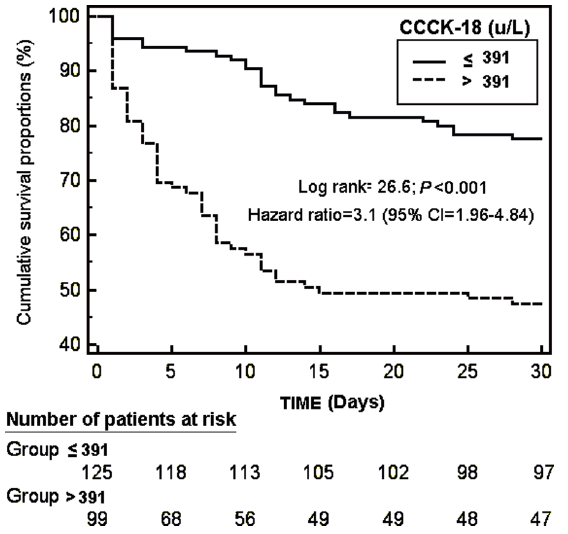
Figure 2. Survival curves at 30 days using serum caspase- cleaved citokeratin (CCCK)-18 levels higher or lower than 391 u/L.